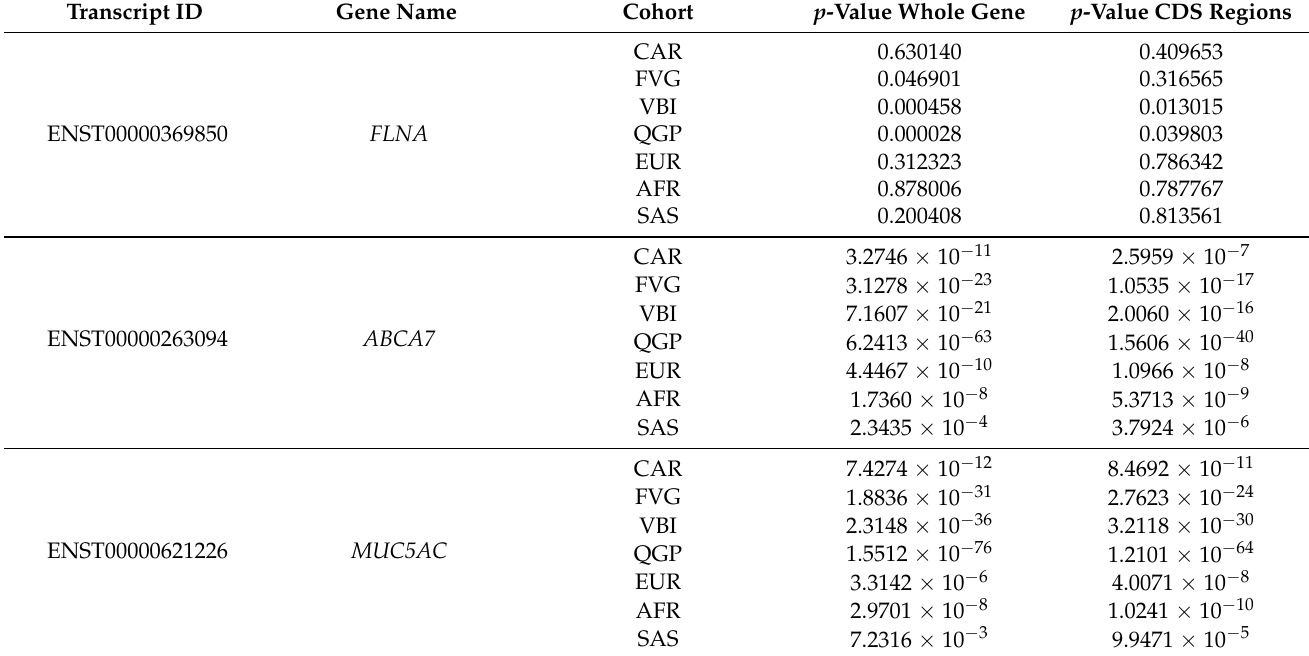
Table 4. Comparison of Singleton burden between the COVID-19 positive cohort (TOV) and other target and reference populations. The reported p-values refer to the comparison between whole gene singleton burden (“ p -value whole gene” column) and coding regions singletons burden (“ p -value CDS region” column). All singleton counts have been adjusted considering the sample size of each